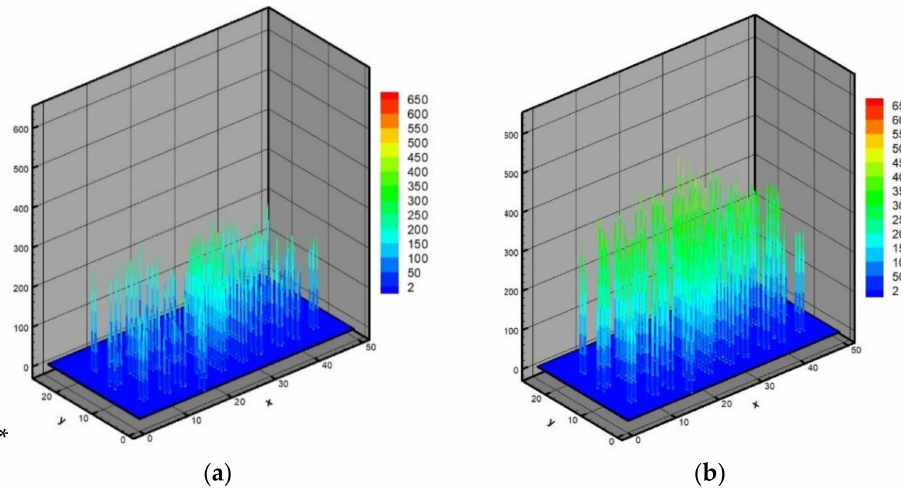
Figure 12. Bearing capacity of piles in October 2021 ( a ) and in November 2021 ( b ) in tf/m 2